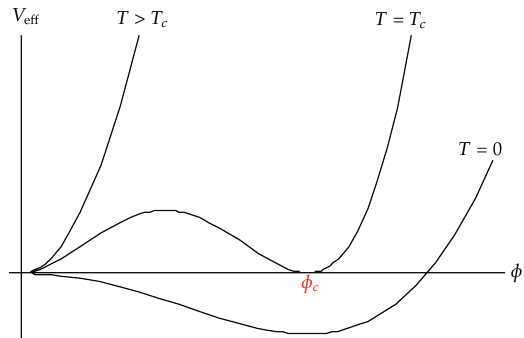
Figure 1: Typical forms of the effective potential in a case of the first- order phase transition for 𝑇 = 0 , 𝑇 = 𝑇 𝑐 , and 𝑇 > 𝑇 1